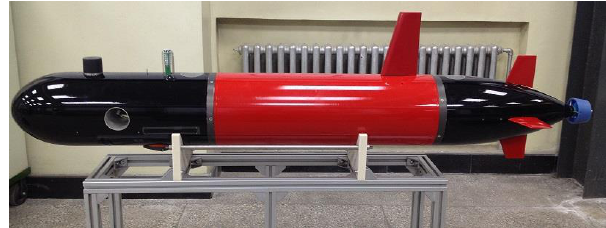
Figure 7. Unmanned underwater vehicle (UUV).